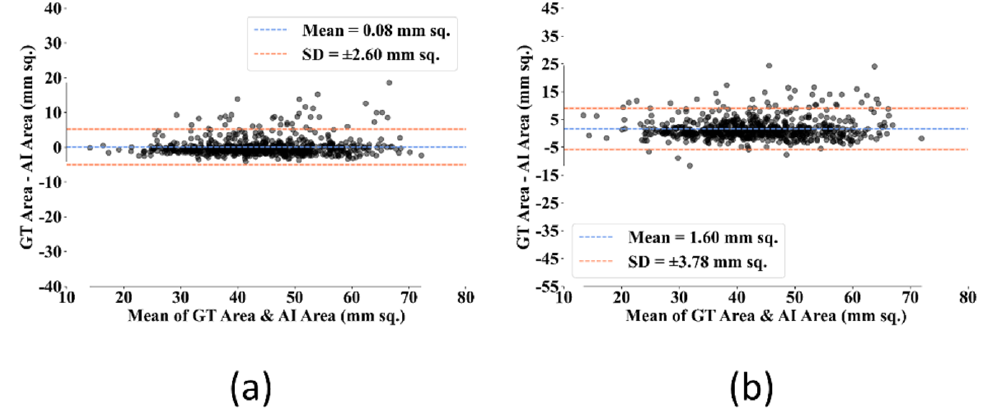
Figure 17. Bland ‐ Altman plots for AI ‐ estimated and GT area for ( a ): UNet model, ( b ): UNet+ model.